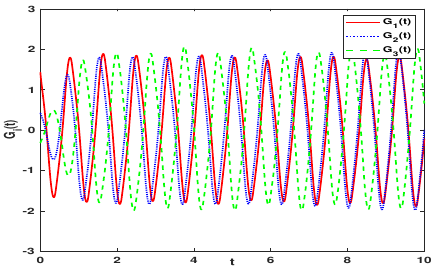
Figure 15. The transmitted signals G i ( t ) .